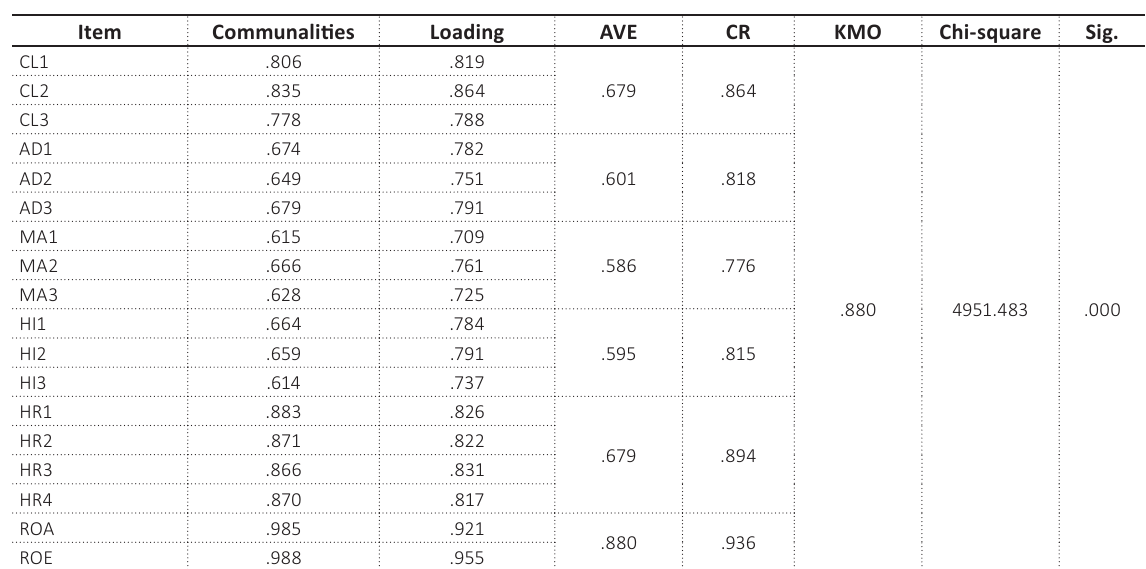
Table 2. Exploratory factor